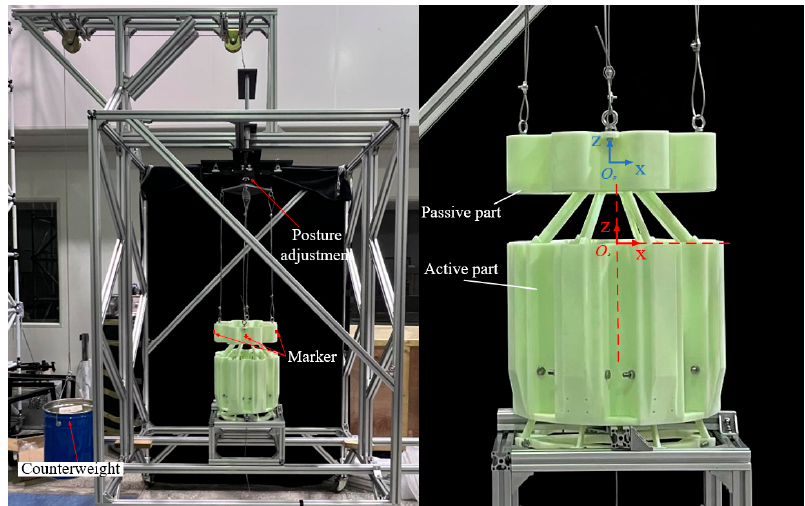
Figure 17. Capture and docking experimental rigs. Table 5. The initial coordinates of the center of the passive part